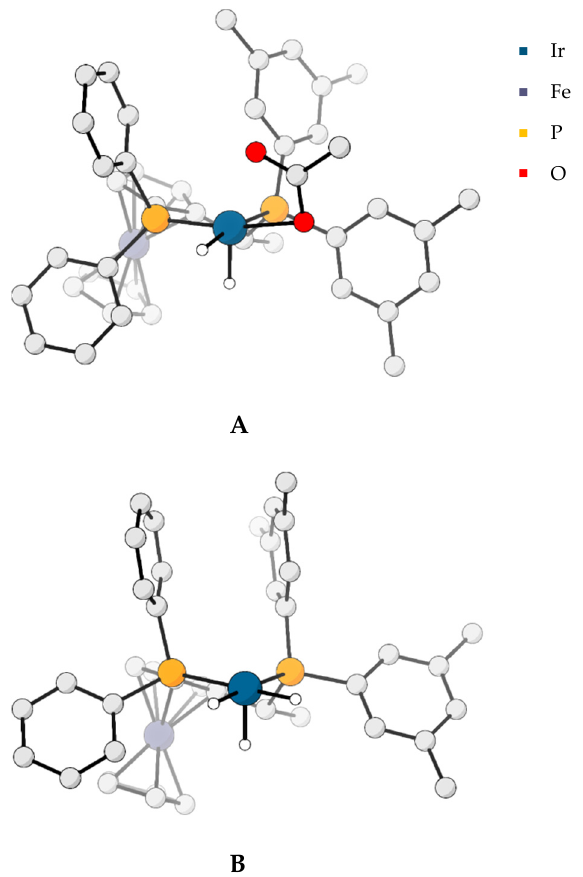
Figure 4. Iridium dihydride ( A ) involved in dihydrogen splitting and iridium trihydride ( B ) involved in hydride transfer. C-H hydrogens were omitted for clarity.